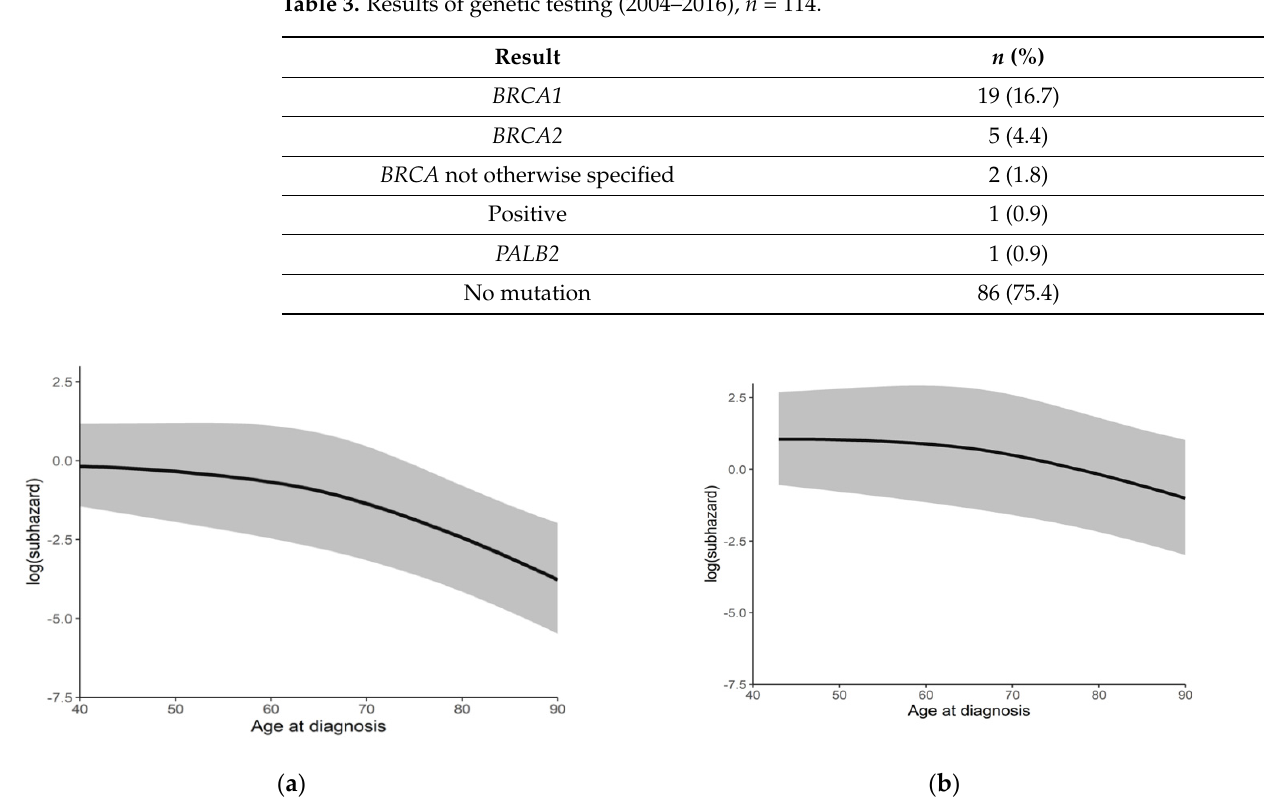
Figure 2. Association between age and genetics referral. ( a ) 2004–2013 ( n = 117); ( b ) 2014–2016 ( n = 110). Black lines indicate log (subhazards), with gray shading demarking the confidence interval.